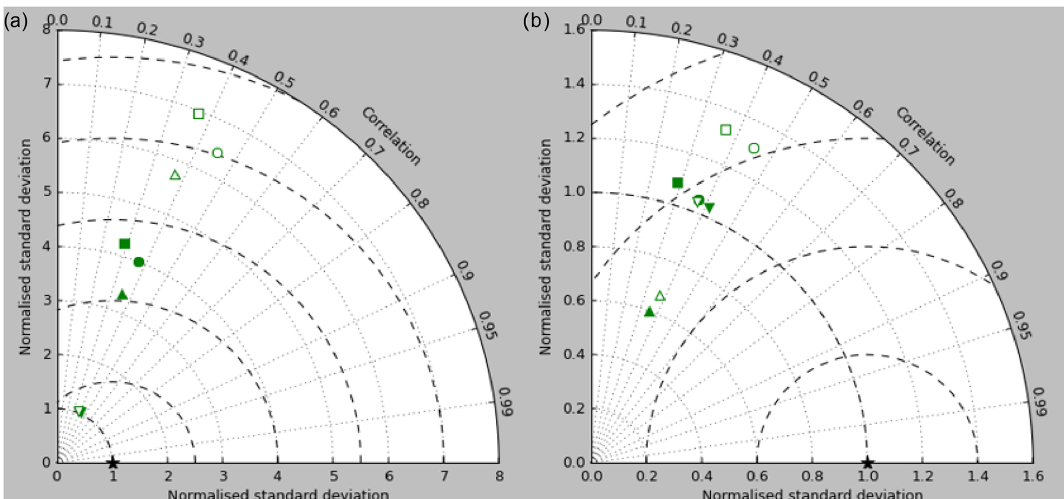
Figure 5. Taylor diagrams of model surface chlorophyll compared to the GlobColour product. Solid symbols represent correlations and standard deviations from points in all parts of the ocean (except inland seas), while open symbols have had a mask applied to remove the Arctic Ocean and two grid boxes around the coast, as explained in the text. Squares represent the annual mean of all points, while circles, up-pointing triangles and down-pointing triangles respectively represent the midpoint, amplitude and phase of the sine curve that best fits the seasonal cycle (where the variance of the residual is less than half the variance of the cycle). The diagram in (a) uses the raw model results, while that in (b) uses the model chlorophyll scaled to give a comparable global mean to the observations (again as explained in the